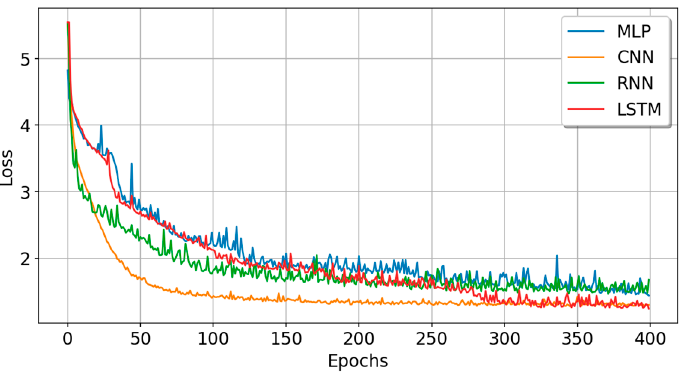
Figure 15. Attack accuracy of the four models.